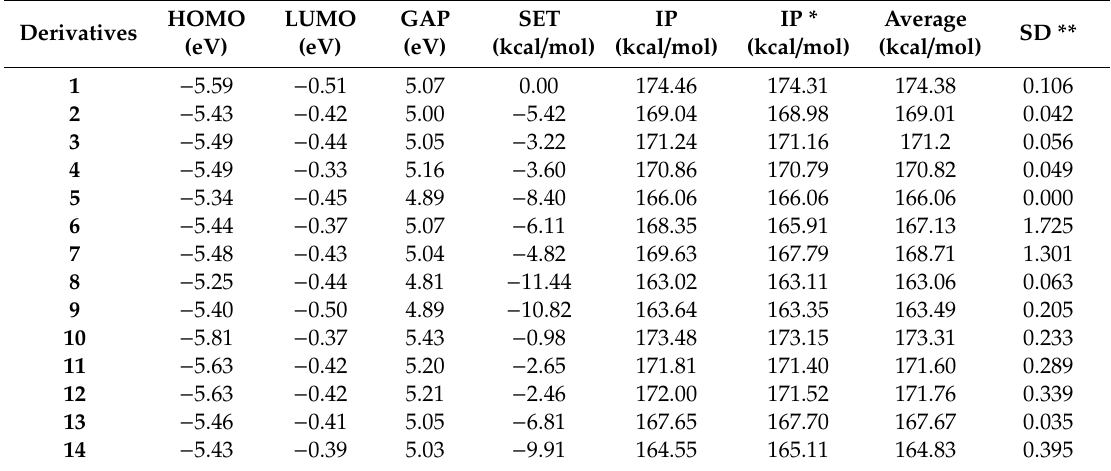
Table 2. Theoretical properties of sesamol and related derivatives using B3LYP/6-311++G(2d,2p).